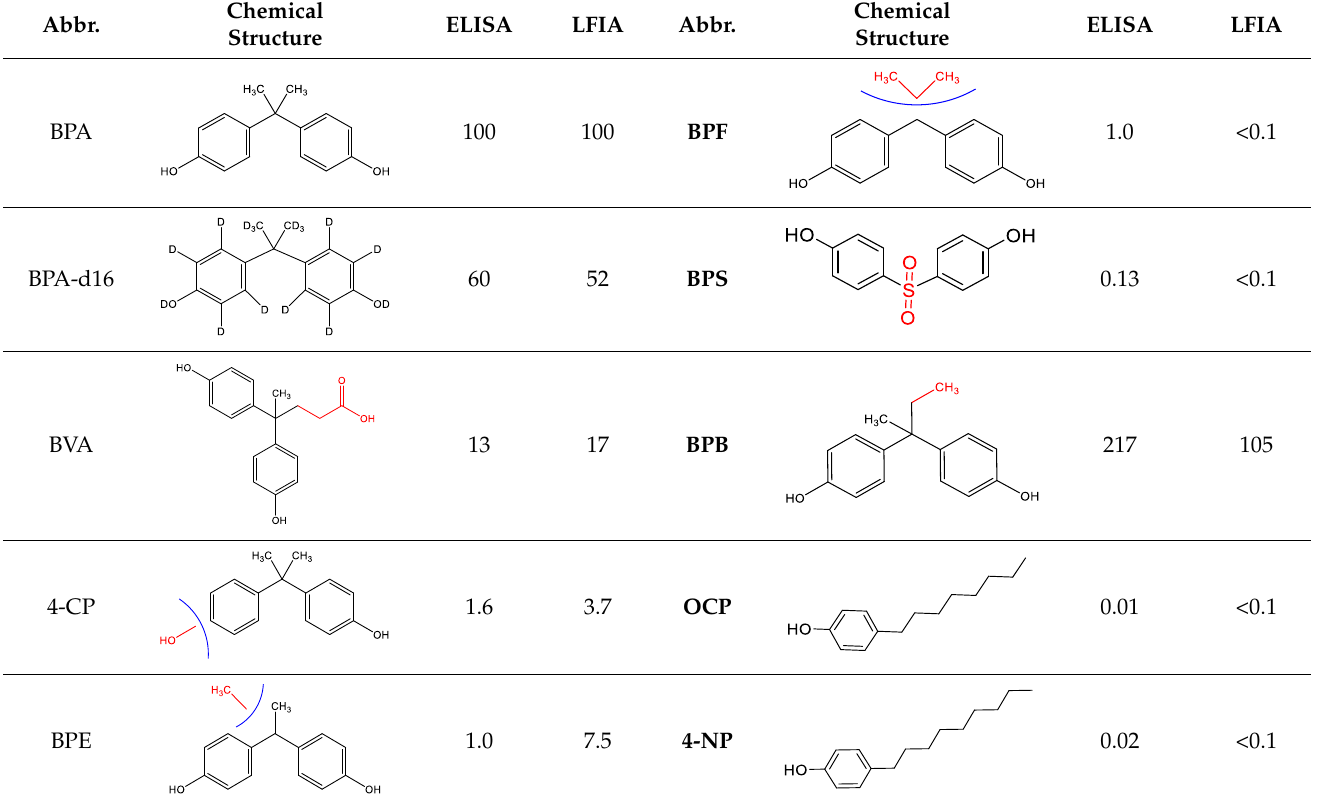
Table 1. Parameters of visual and instrumental detection of BPA in the developed LFIA.